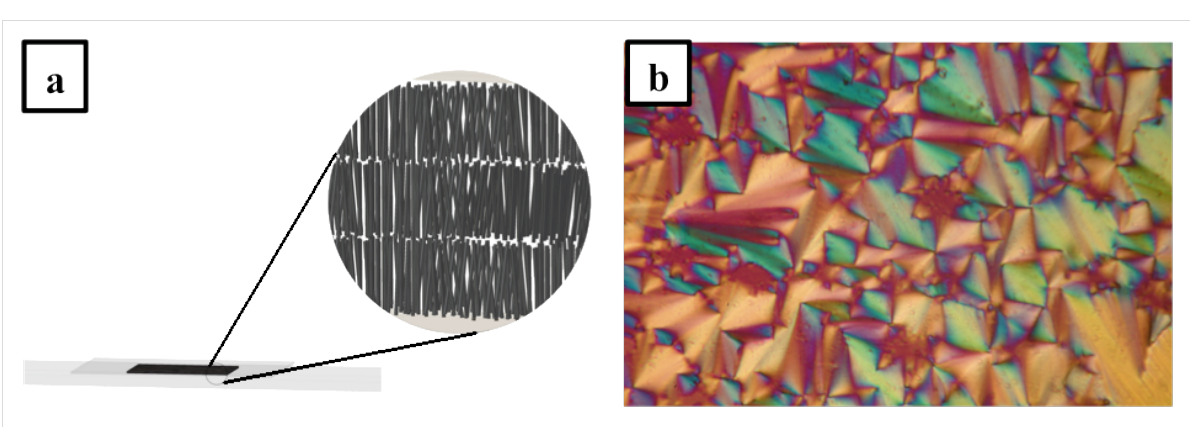
Figure 5: (a) Illustration of a single homeotropic monodomain, which is observed as a black isotropic texture under POM, (b) focal conic texture observed at 80 °C with 1 8 (spacer Mylar foil 100